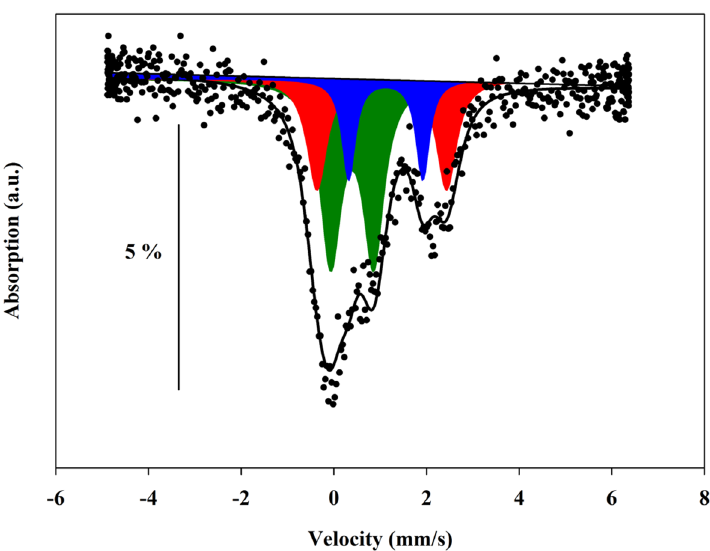
Figure 4. Synchrotron Mössbauer spectrum of the amphibole LE5-AMPH single crystal. Black dots: experimental data; black solid line: full absorption spectrum integral fit; green (Fe 3+ ), blue and red (Fe 2+ ) areas: individual absorption subspectra. Percentage bar indicates the relative